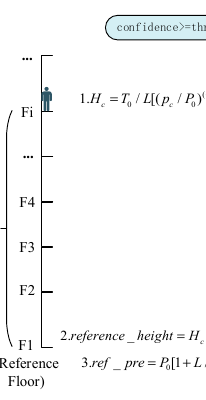
Δ as Fig. 4 Figure 3. The floor prediction using the BPFP.